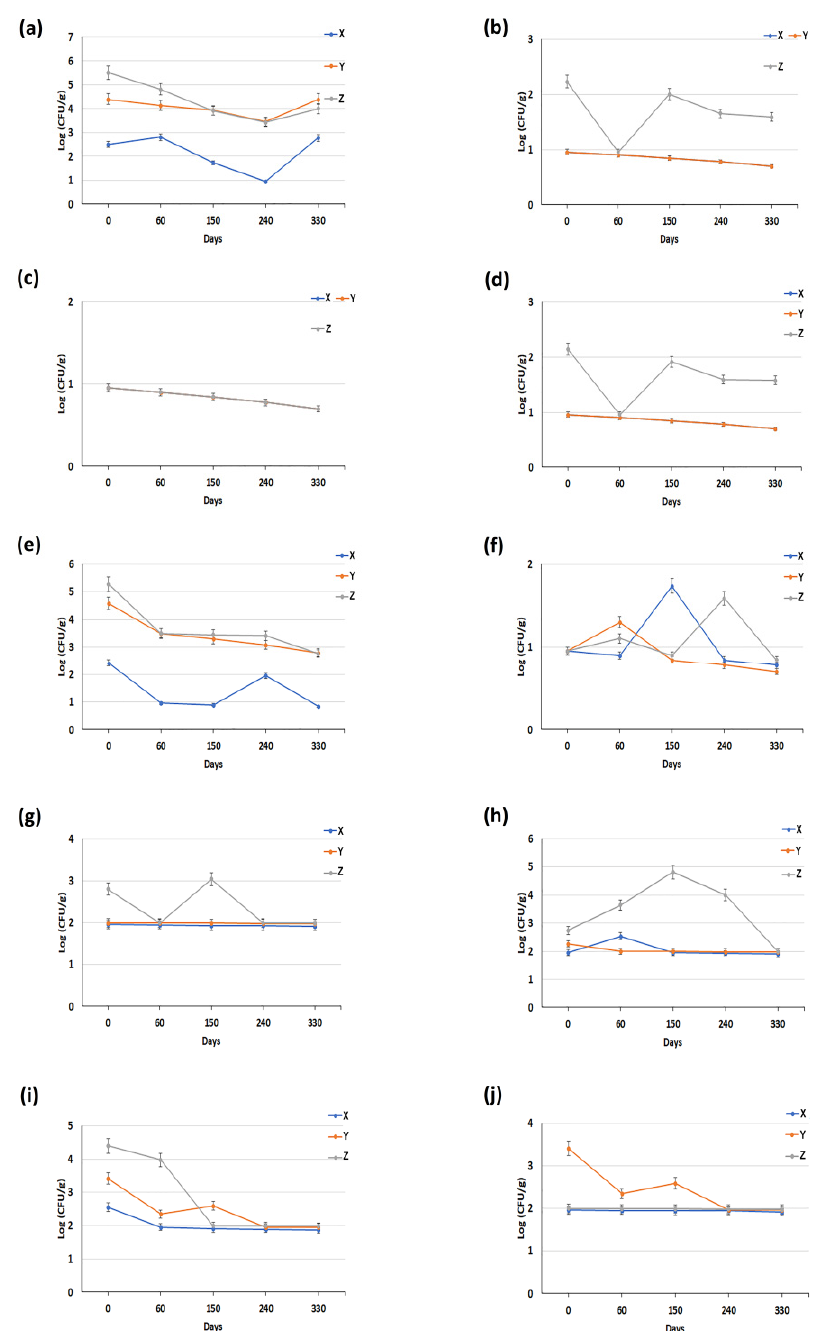
Figure 3. Microbiological data on Buffalo Mozzarella cheese collected from three different dairies (X, Y and Z). Quantification of: ( a ) total bacterial count; ( b ) coliforms; ( c ) Escherichia coli ; ( d ) Enterobacteriaceae; ( e ) lactic acid bacteria; ( f ) coagulase-positive staphylococci; ( g ) Pseudomonas spp.; ( h ) psychrotrophic; ( i ) yeasts and ( j ) moulds. Each datum represents the mean ± SD of the different microbiological analyses, each performed in triplicate.